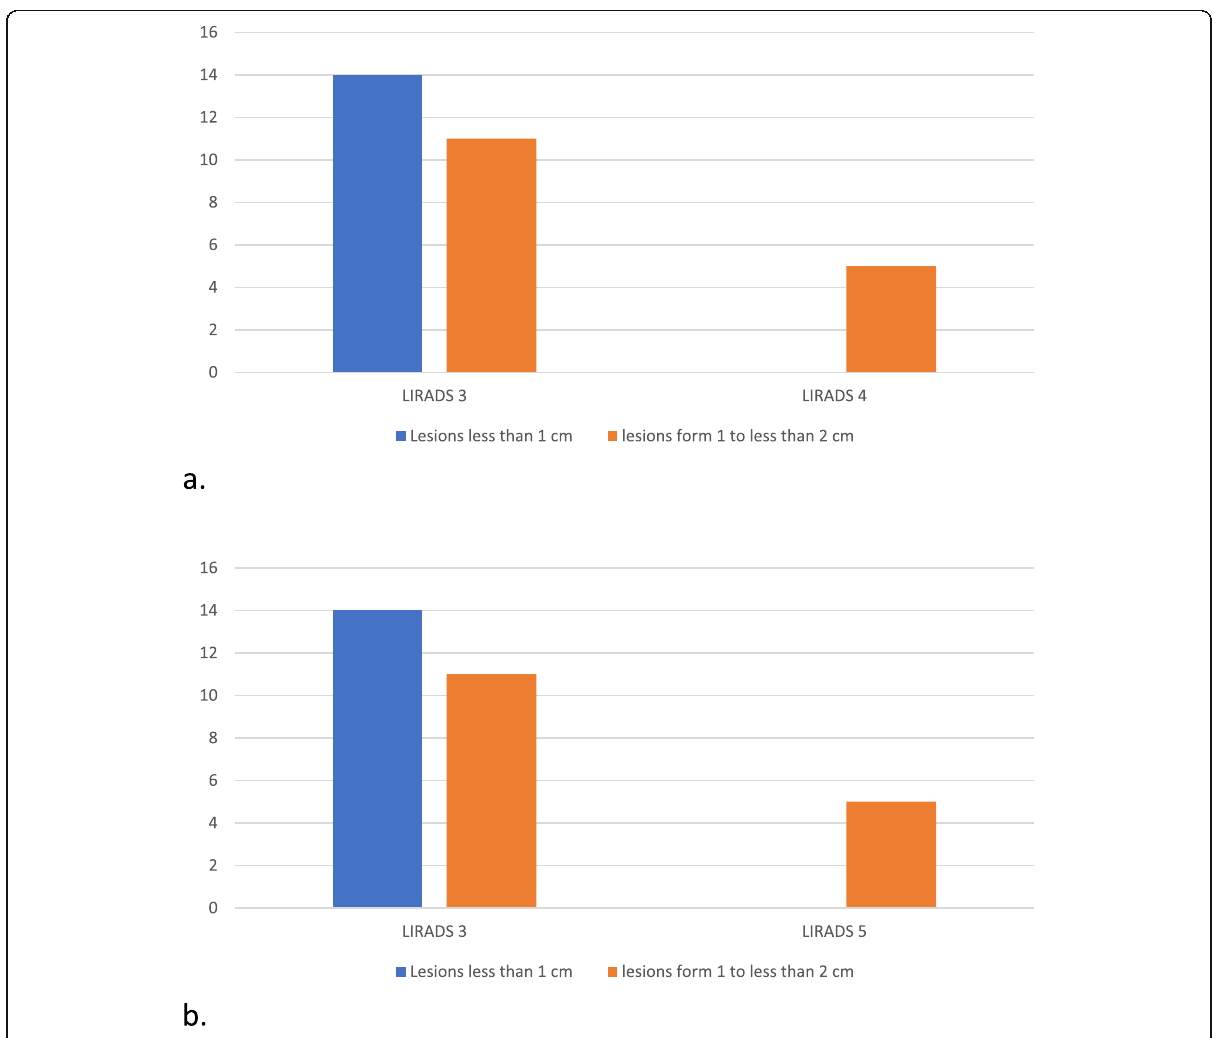
Fig. 1 LIRADS classification of the lesions in the initial study using LIRADS version 17 ( a ) and version 18 ( b